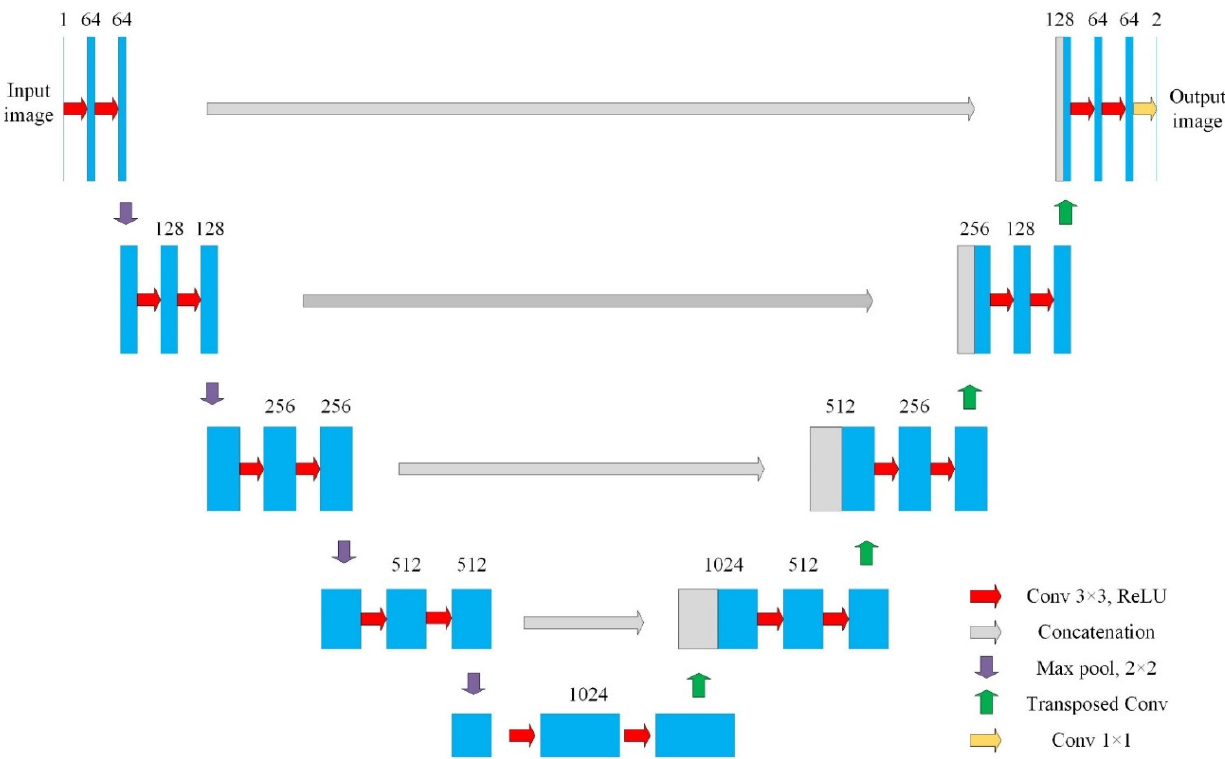
Figure 6. The structure of UNet.